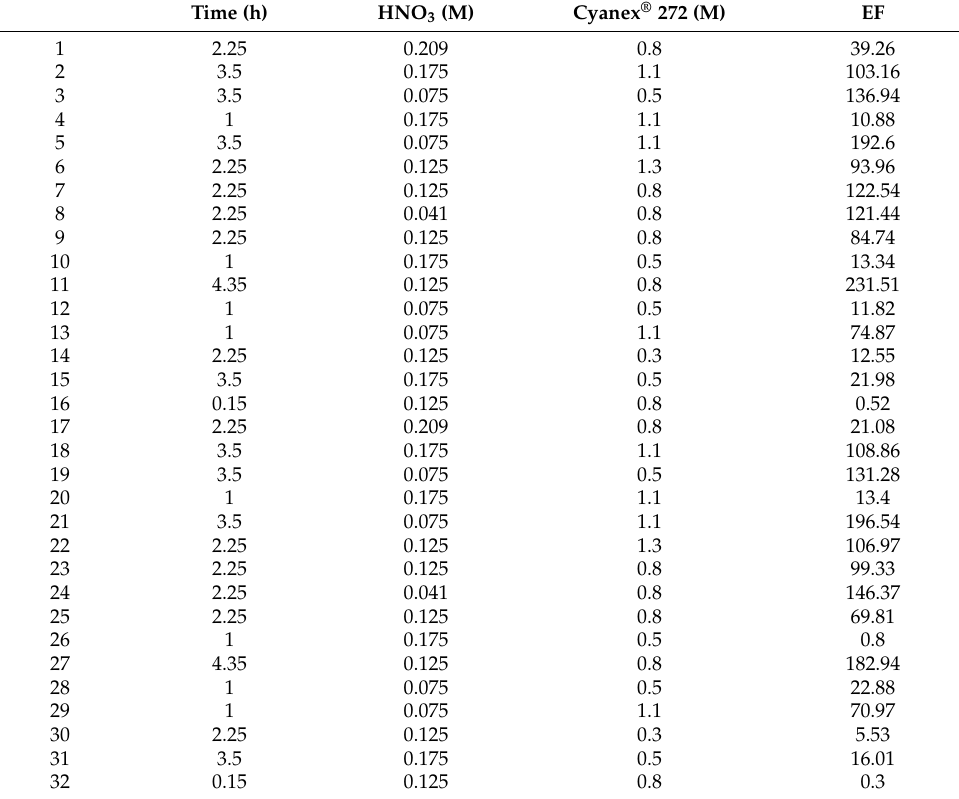
Table 1. Experimental conditions for the central composite design and EF values